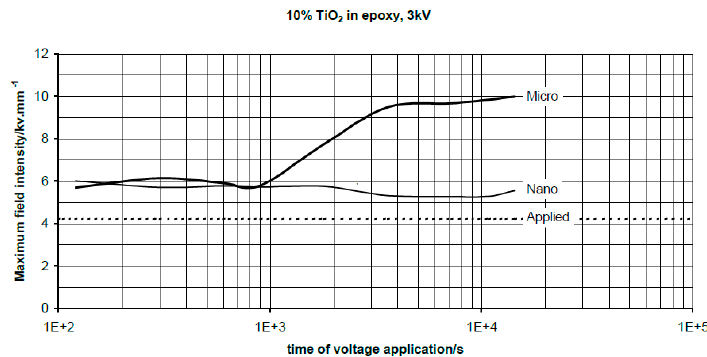
Figure 30. Maximum field intensity as a function of voltage time application on epoxy/TiO